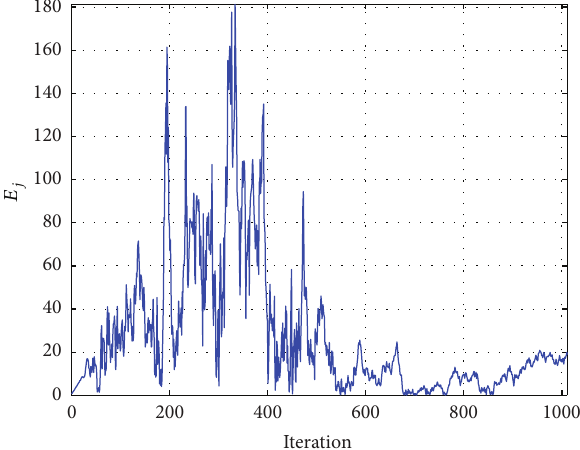
Figure 13: 3D scenario diagram of Case 4.